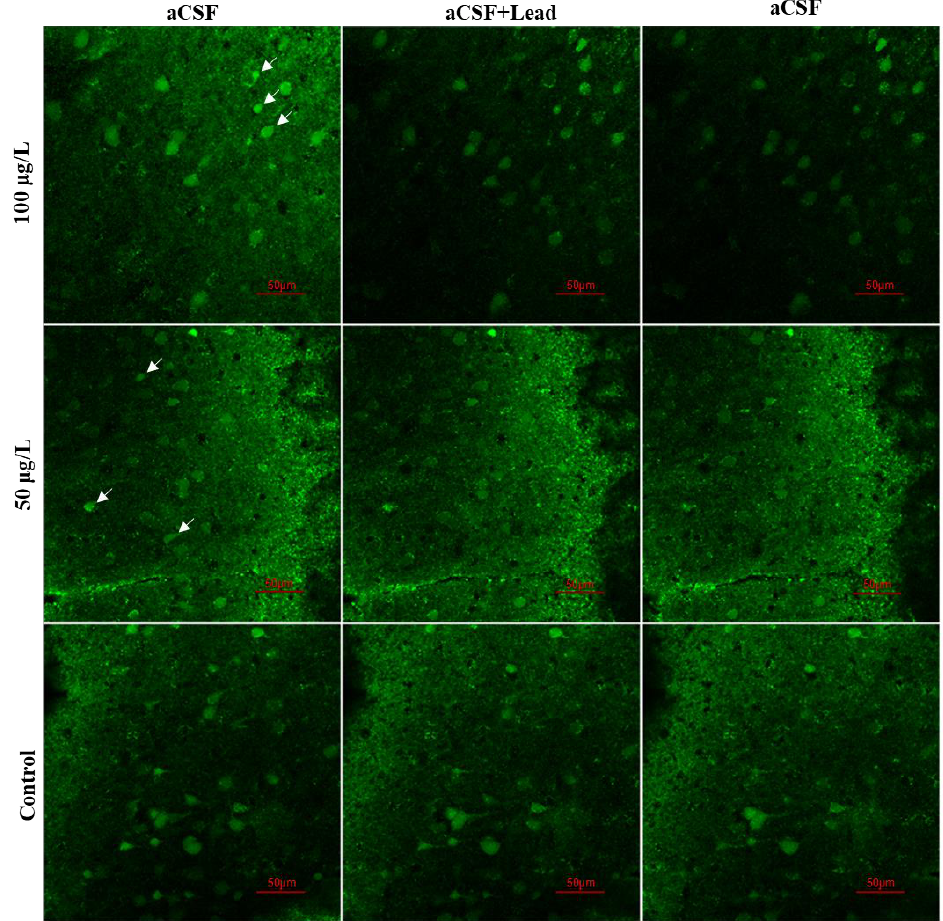
Figure 4. Representative confocal images of Ca 2+ in the brain slices. The cells indicated by the white arrows are neurons with reduced Ca 2+ signaling after lead exposure. Dynamic loss of Ca 2+ fluorescence intensity can be observed from left to right: the left column shows the fluorescence intensity of brain slices before lead exposure, the middle column shows the fluorescence intensity after lead exposure, and the right column shows the fluorescence intensity after the removal of lead exposure. The control group was observed in aCSF. Scale bar, 50 μm.